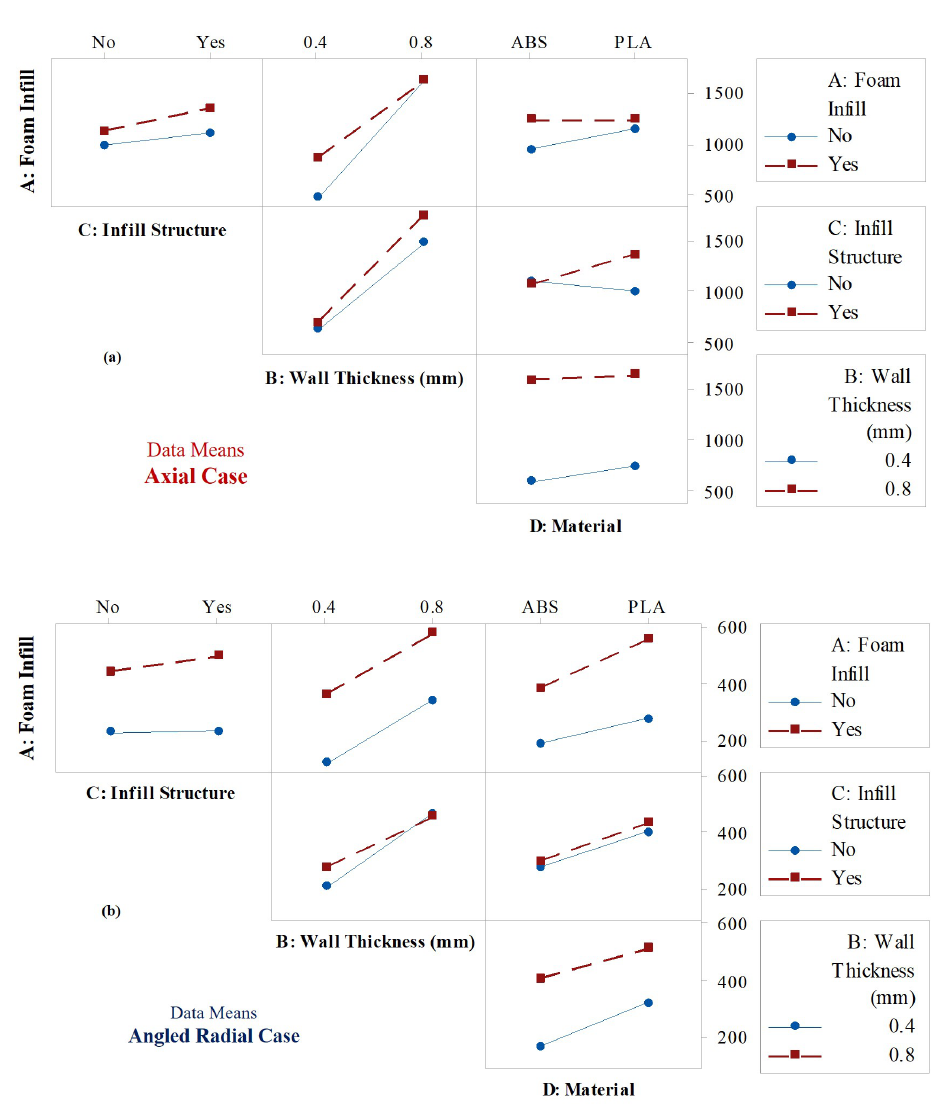
Figure 7. Interaction plots for the selected experimental factors for: ( a ) axial loading and ( b ) angled radial